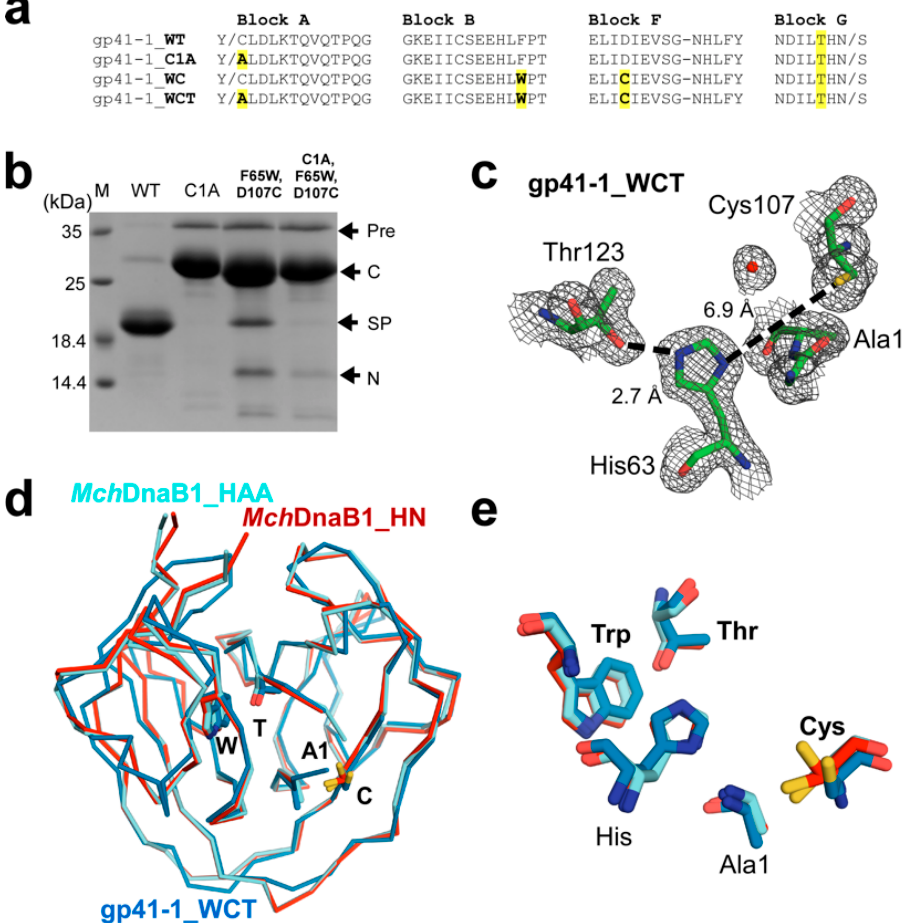
Figure 3. Conversion of a class 1 into a class 3 intein by grafting the WCT motif. ( a ) Sequence alignment of the engineered variants of the gp41-1 intein with different mutations. The WCT motif and Cys1Ala substitution are highlighted in yellow. ( b ) SDS-PAGE analysis of protein cis -splicing by the engineered variants with indicated mutations. M, molecular weight marker; WT, wild-type; Pre, precursor; C, C-cleavage product; SP, splicing product; N, N-cleavage product. ( c ) A close-up of the electron density map observed for the active site of the WCT motif-grafted class 1 intein, gp41-1_WCT with the same orientation as the structures shown in Figure 2a. ( d ) Superposition of the three crystal structures of the gp41-1 intein with the WCT motif (gp41-1_WCT) (blue), Mch DnaB1_HN (red), and Mch DnaB1_HAA (cyan). The residues of the WCT motif are shown by stick models and indicated, together with the first residue of the inteins. ( e ) A close-up of the WCT motif together with His in the catalytic triad from the superposition of the three structures shown in ( d ).